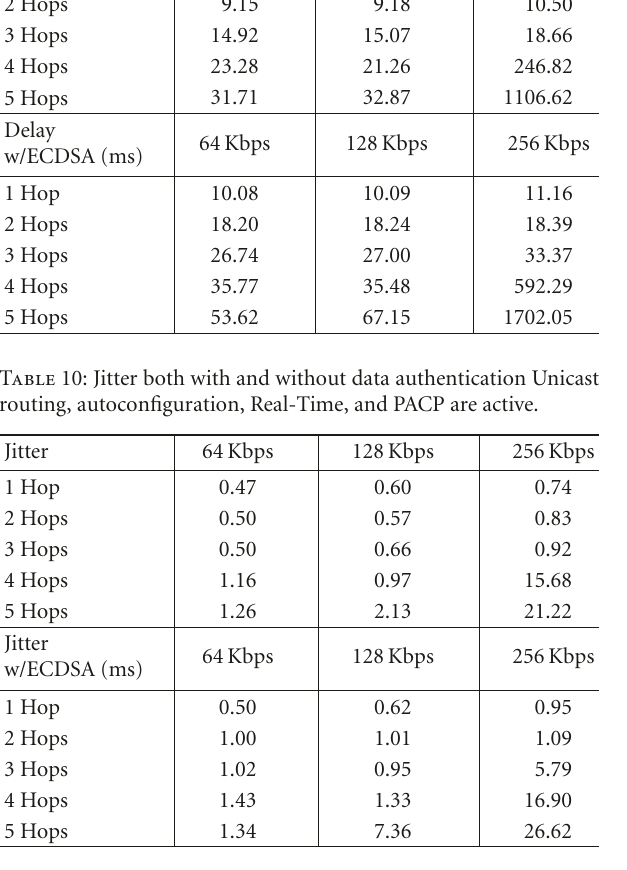
Figure 11: Cumulative jitter for the 256 kbits tra ffi c profile.